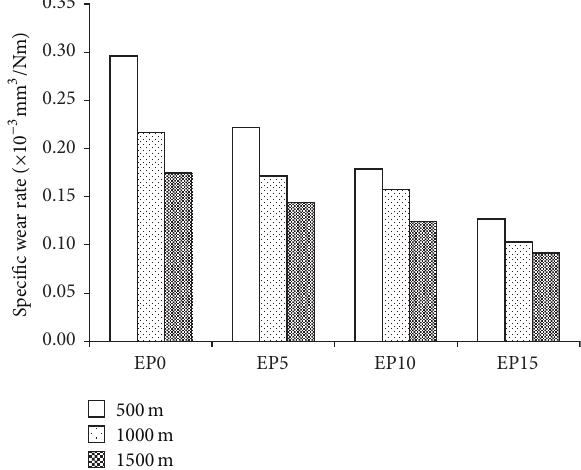
Figure 7: Variation of COF with sliding time (min).